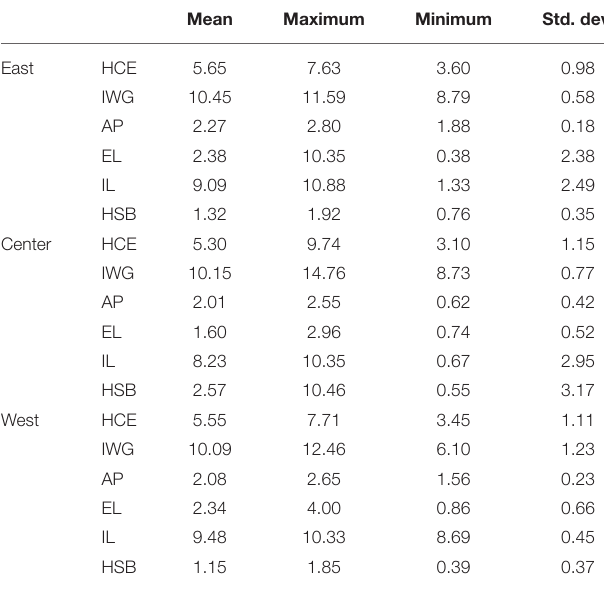
TABLE 2 | Results of the relationship between the two indexes in eastern China. Variable Estimated value OLS se